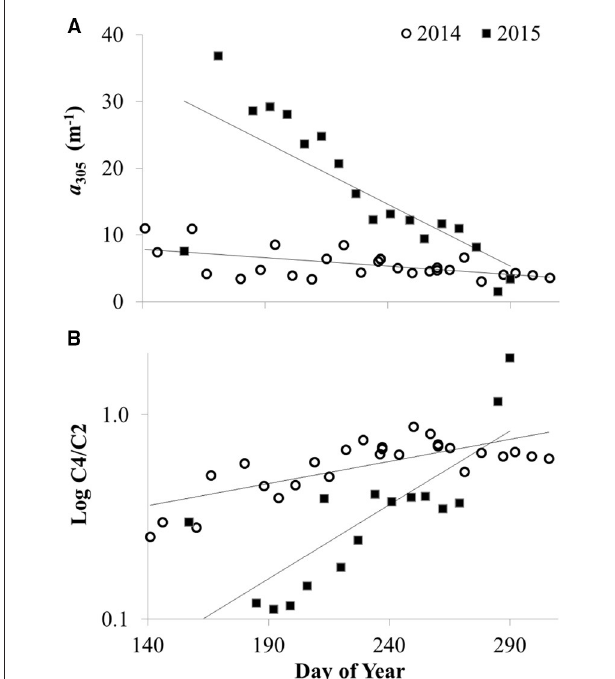
FIGURE 6 | CDOM concentration and source vs. day of the year in 2014 and 2015 at site 2 (a near-shore station closest to the Maumee River) in Lake Erie. (A) CDOM concentration as measured by the absorption coefficient at 305nm ( a 305 ). (B) CDOM source given by the ratio of CDOM fluorescence components: amino acid component C4 divided by terrestrial component C2 (C4/C2). Lines show linear regression fit for slopes significantly different than zero ( p < 0.01 ).